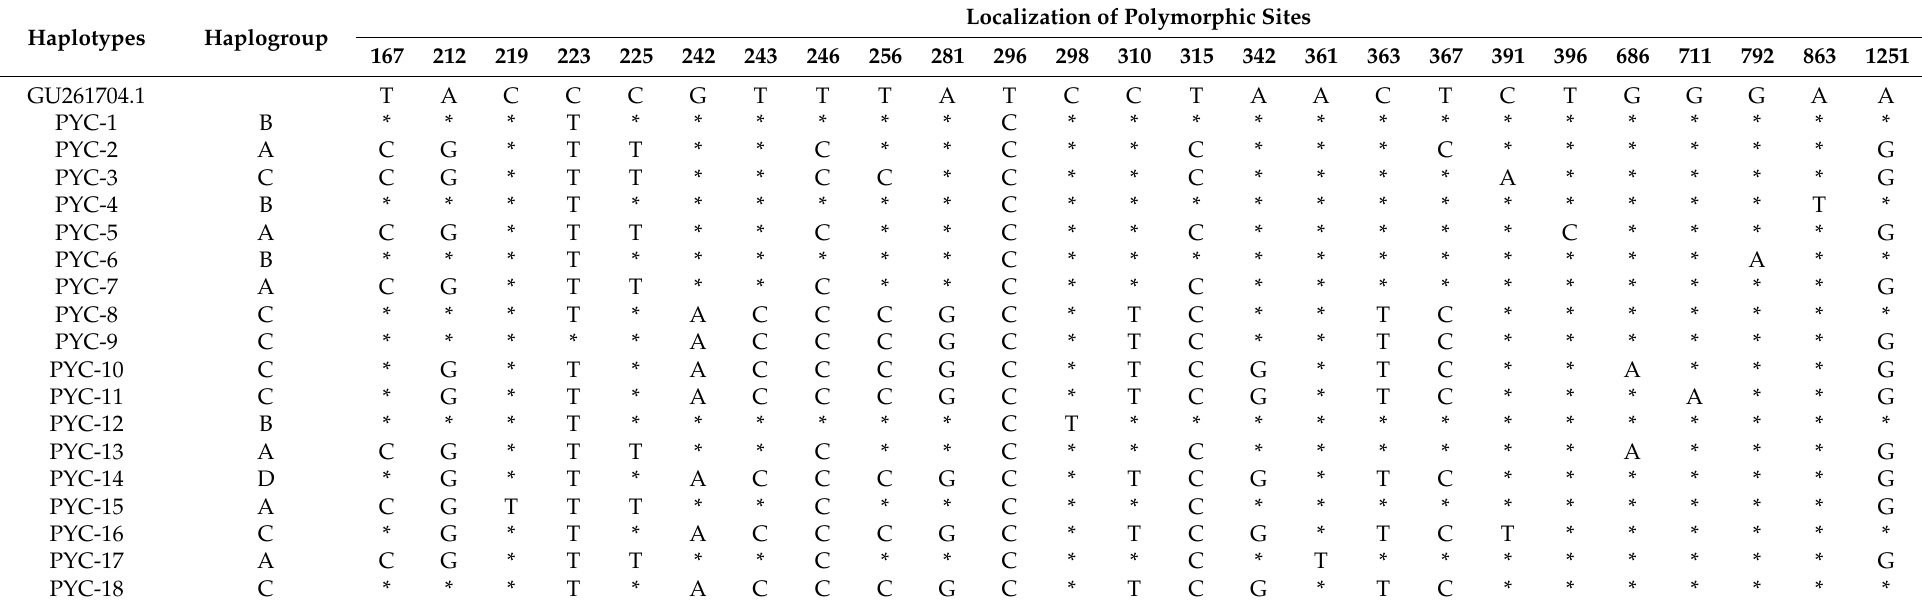
Table 3. Haplotypes and polymorphic sites of the mtDNA D-loop sequence of the Pingpu Yellow chicken. Haplotypes